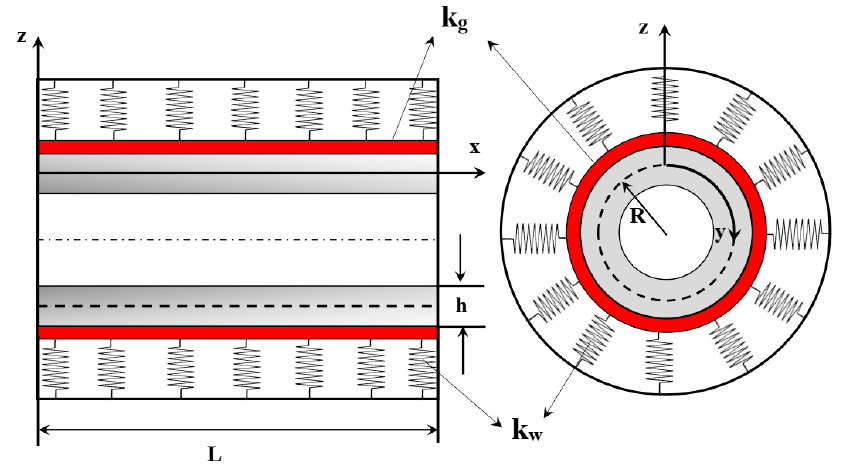
Figure 1. Geometrical scheme of a bi-directional (BD)-functionally graded (FG) porous cylindrical shell embedded in an elastic foundation.